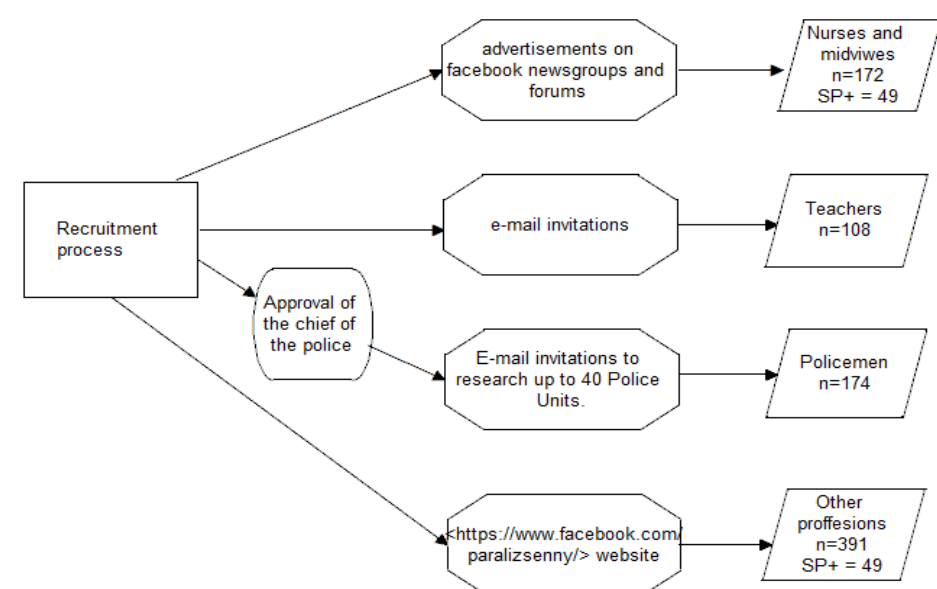
Figure 1. Study participants and procedure: flowchart of the procedure of recruiting participants to study.